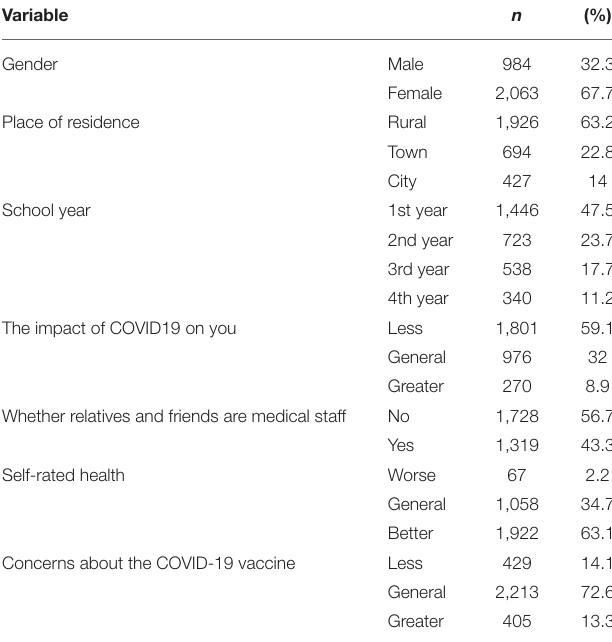
TABLE 2 | Analysis of variables for possible association with willingness to get COVID-19